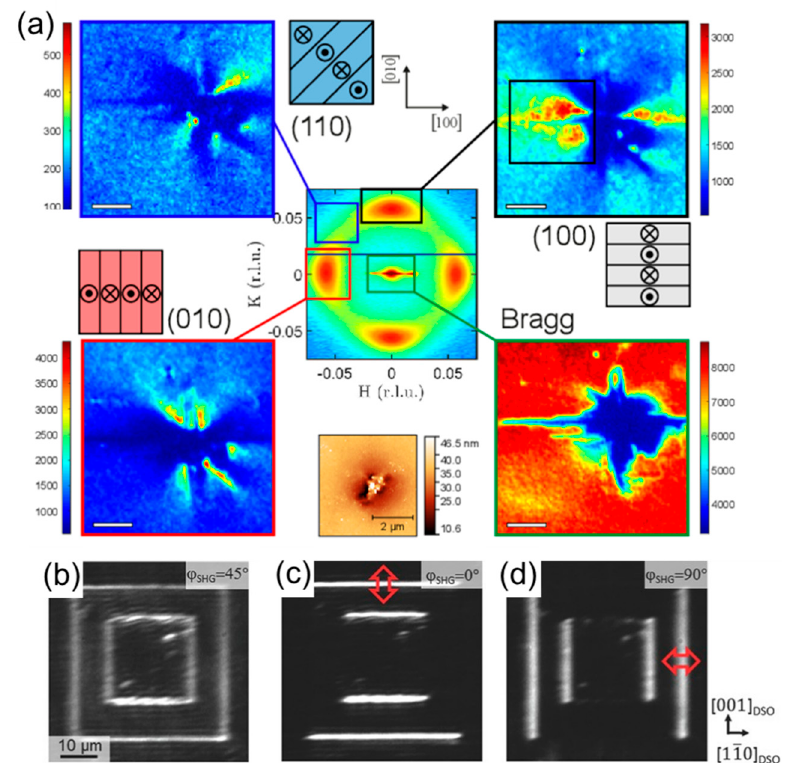
Figure 6. ( a ) In-plane local reciprocal space maps (RSM) around the out-of-plane (002) Bragg reflection with satellite peaks on a diffuse scattering ring corresponding to the stripe domain periodicity in the PTO/STO superlattice. Spatially scanning the area at the x-ray angles of the satellite peaks in the (100), (110) and (010) direction around the defect shows the domain type dependence on the defect shape, i.e., the domains lie parallel to the lines of the defect. Reprinted with permission from [119]. ( b ) SHG images of voltage-poled 180° domain walls in PZT films grown on SRO buffered (DSO) show the total in-plane polarization, the polarization parallel to the ( c ) [001] DSO direction and ( d ) [110] DSO direction. Reprinted with permission from [99], copyright Wiley-VCH Verlag GmbH and Co. KGaA, 2016.